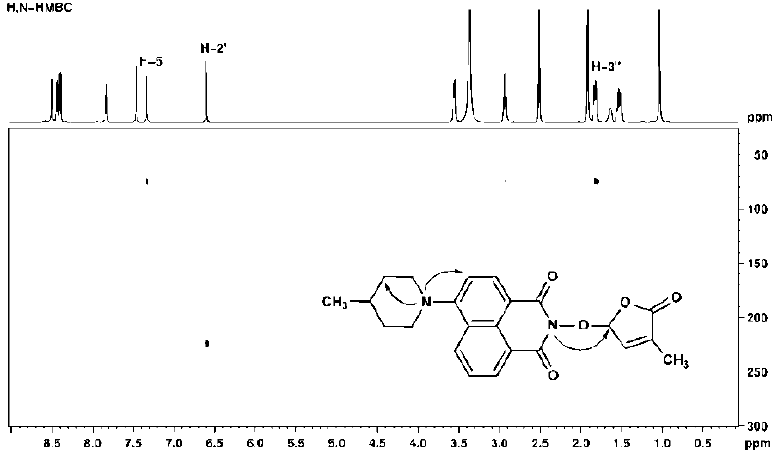
Figure 1. 1 H- 15 N HMBC spectrum for compound 7 recorded in DMSO-d6 at 600 MHz.